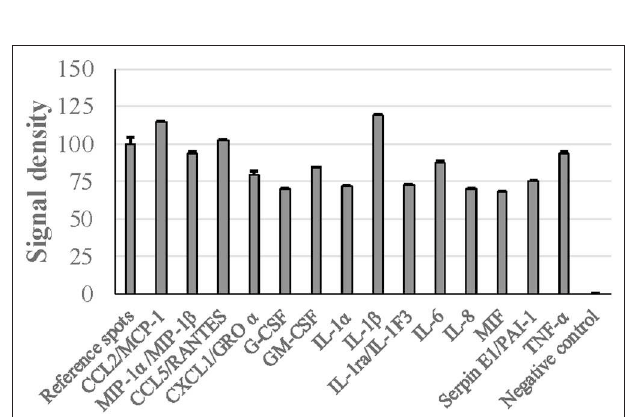
FIGURE 5 | Cytokine induction from human PBMCs by G. adiacens secretome preparation. Fractionated human PBMCs were stimulated by G. adiacens secretome preparation for 24h. The cytokines produced were detected by using Proteome Profiler TM membrane array. Means (SD) of signal densities of spots were determined using Gene Tools analysis software in Syngene Imaging